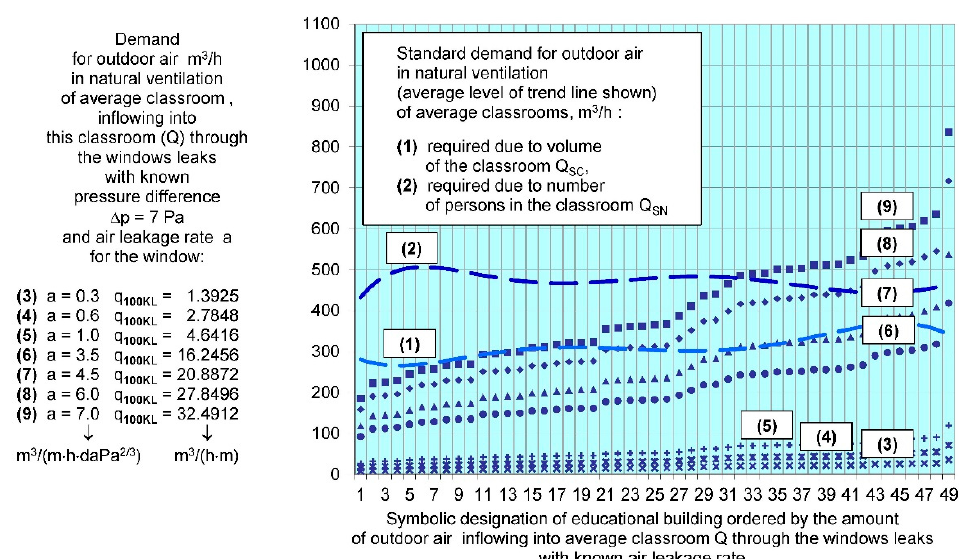
Figure 13. The quantity of air flowing into the classroom from the outside through the windows with different rates of outdoor air leakage a , in m 3 /(m h daPa 2/3 ) and their corresponding outdoor air permeability q 100KL in m 3 /(h · m) for ∆ p = 7 Pa.